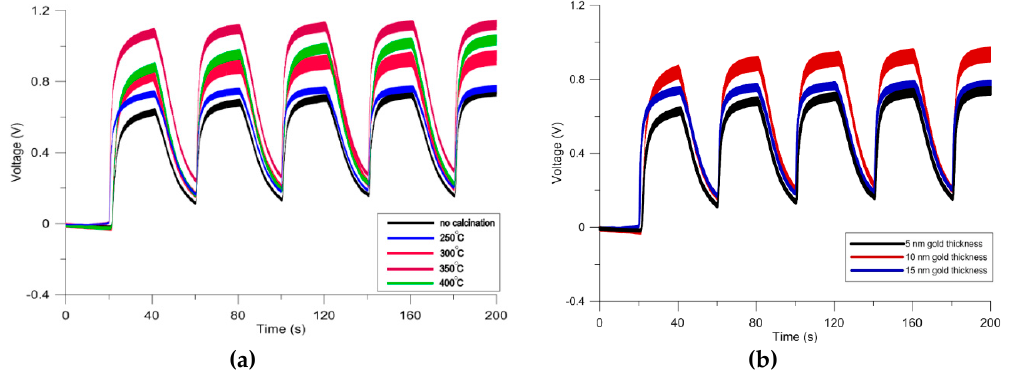
Figure 3. ( a ) Response of the sensors with different calcination temperatures to 1000 ppm methanol; ( b ) Test results of sensors with different thicknesses of deposited gold to 1000 ppm of methanol.